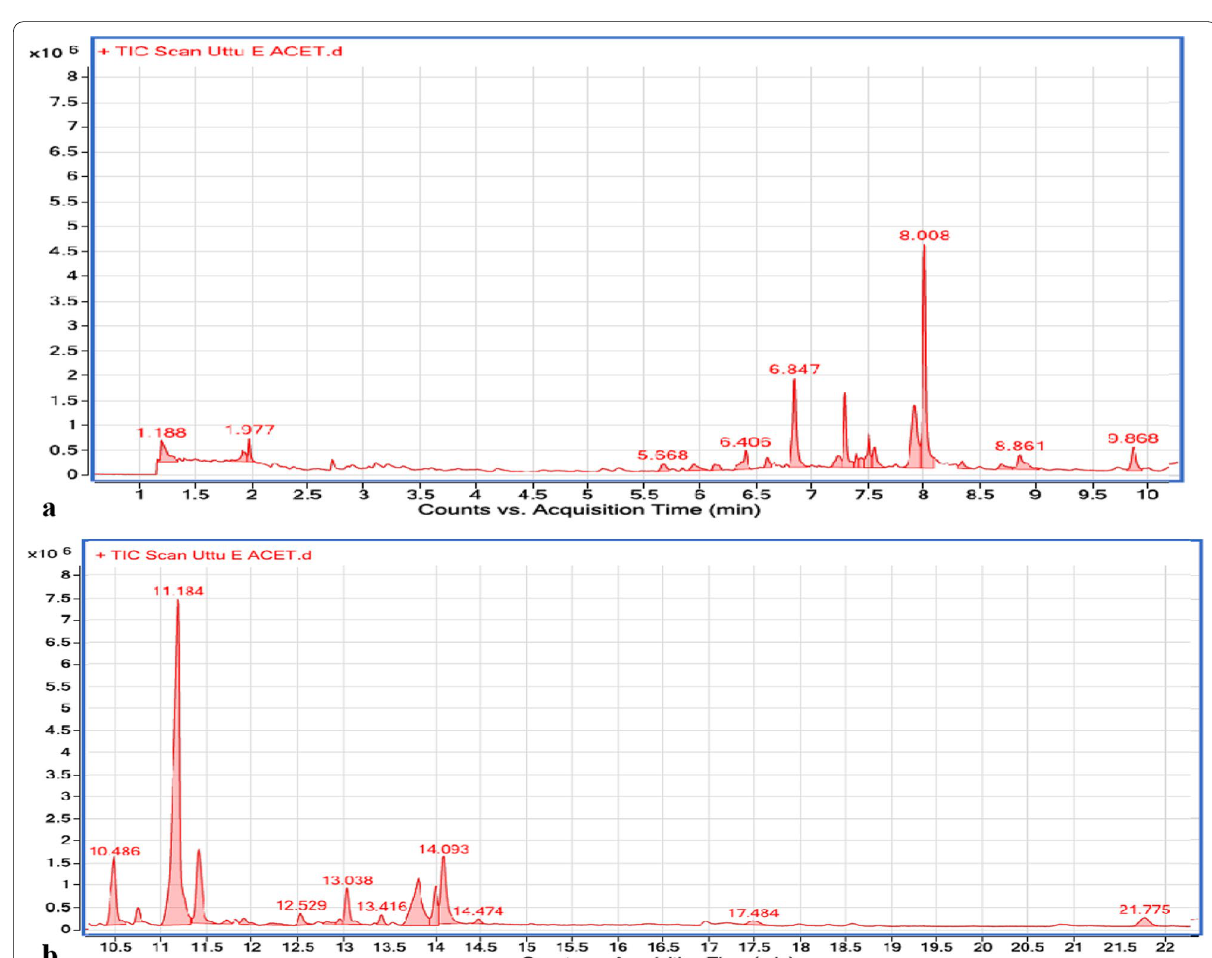
Fig. 2 a The chromatogram of phytoconstituents in ethyl acetate root bark extract. b The chromatogram of phytoconstituents in ethyl acetate root bark